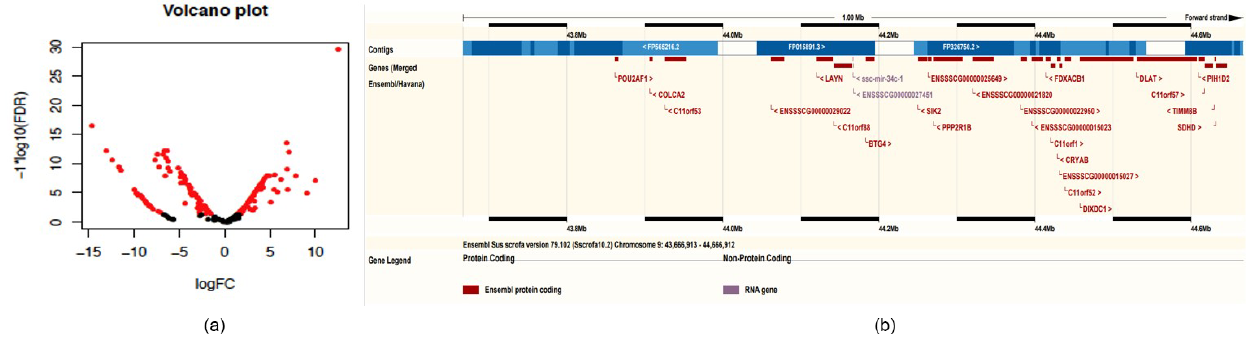
Figure 2. Bioinformatics analysis of microRNA. (a) Volcano plot of differential miRNAs between exosomes and milk (red indicates differ- entially expressed miRNAs). (b) Mapping of the miRNA cluster on chromosome 9.